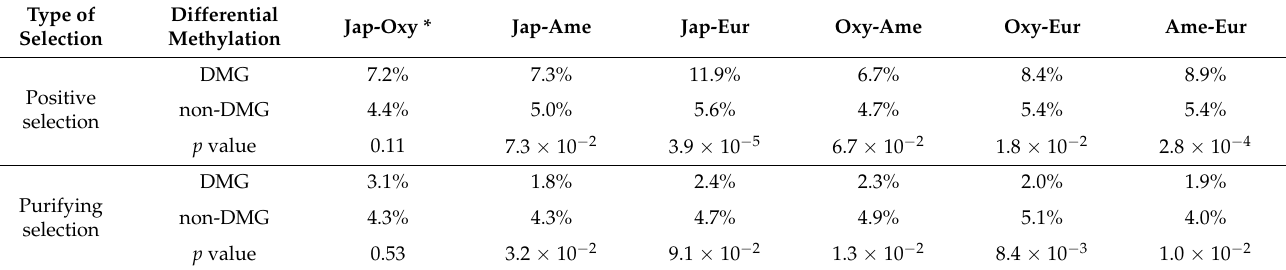
Figure 5. Association between the CG-loss variations and epigenetic variability. ( a ) Top 3000 most variable CG loci containing CG-loss variations. ( b ) Top 3000 most variable non-variant CG loci across 36 accessions that show clade-specific methylation patterns. CG methylation in the hybrids tends to be neutralized, possibly due to heterozygosity. ( c ) Linear regression demonstrates that CG-loss variations explain a large proportion of CG methylation variation. ( d ) Summary of composition of each category regarding whether each CG locus contains a CG-loss variation. Epigenetic variability was determined by standard deviation in methylation β value across all 36 accessions. CG loci with the top 10,000, 10,001–50,000 and 50,001–150,000 largest standard deviation was ordinally labelled as possessing “very high”, “high” and “moderate” variability, respectively. The rest of the CG loci were labelled as possessing “low” variability. ( e ) Association test shows most DMRs were independent of cis-acting SNPs. Results under different significance levels are compared in this exploratory analysis. Table 2. Significant correlation between differential methylation and natural selection.